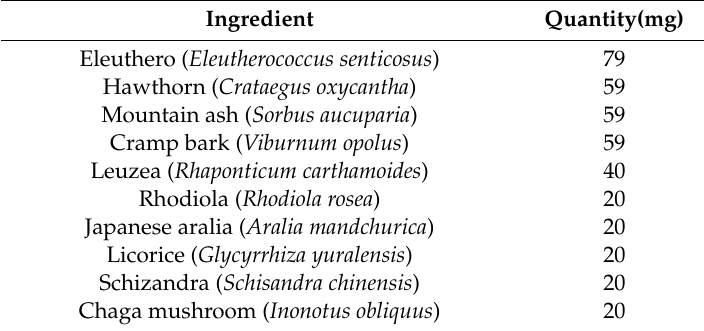
Table 1. Adaptogenic herbs contained in e + shot (mg).